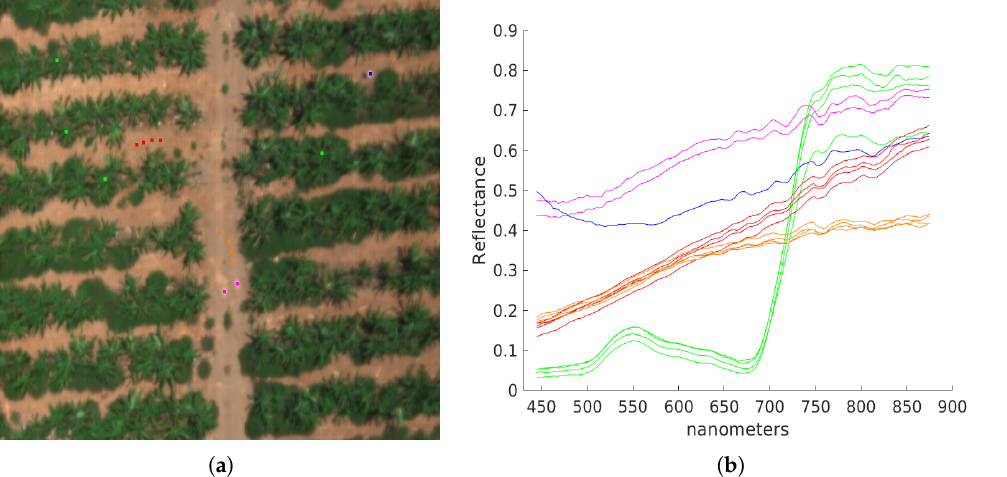
Figure 6. Example of spectral signatures corresponding to some real pixels of the first image used in the experiments (Figure 5a). ( a ) Pixel locations; ( b ) Pixel spectral